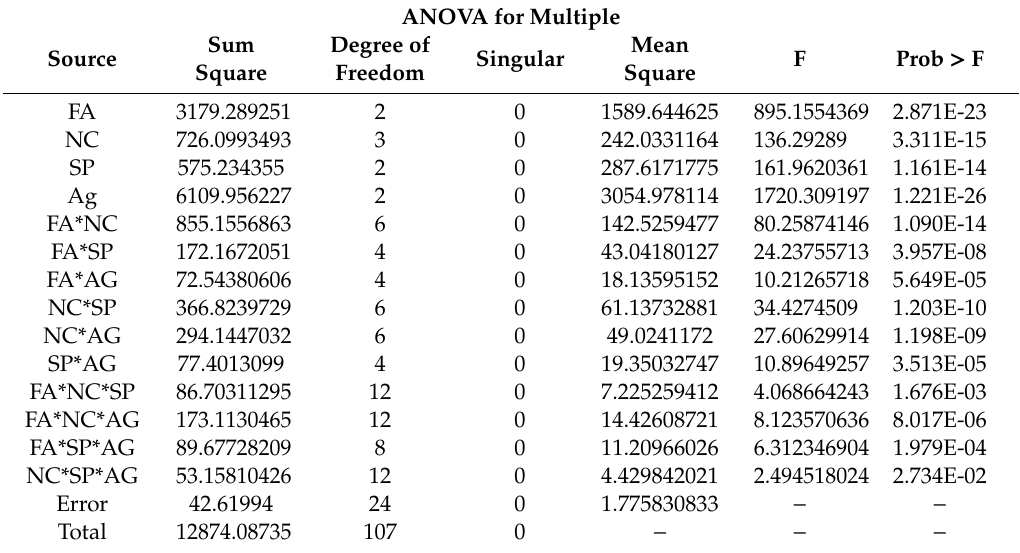
Table 8. Multiple Analysis of Variances (MANOVA) for compressive strength of